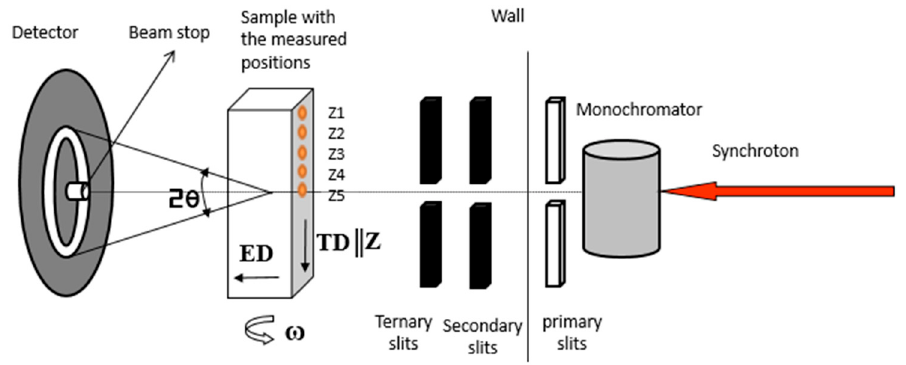
Figure 2. Texture measurement using synchrotron radiation.